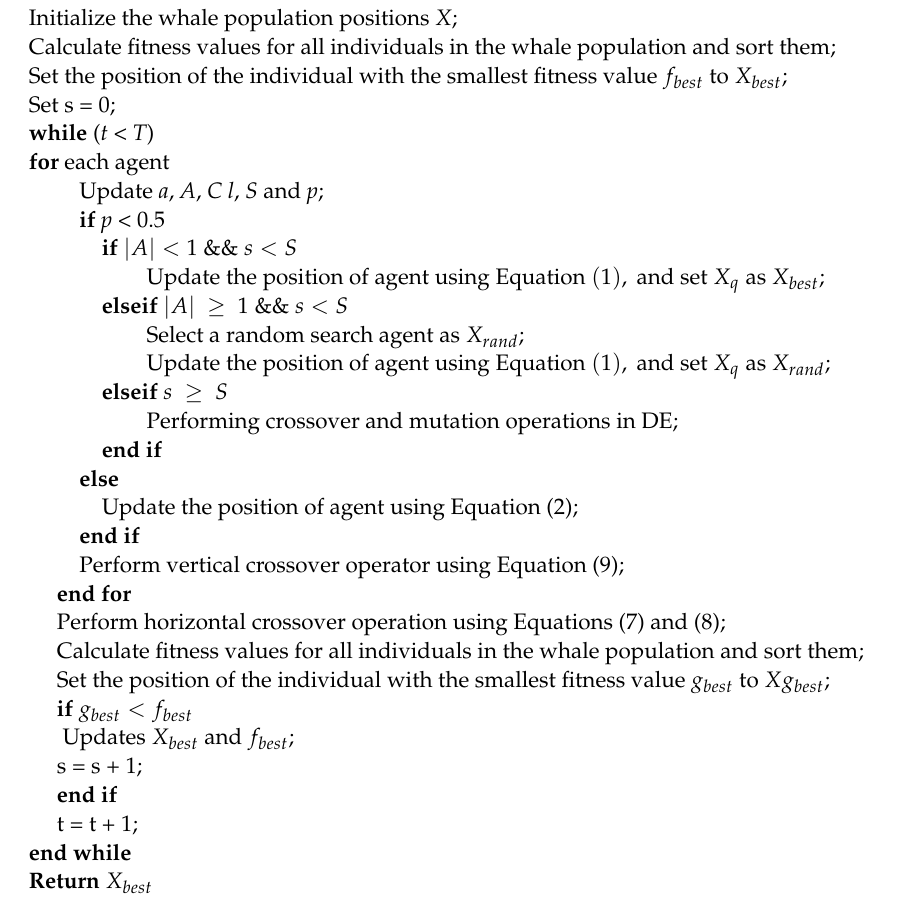
Algorithm 1: The pseudo-code of the